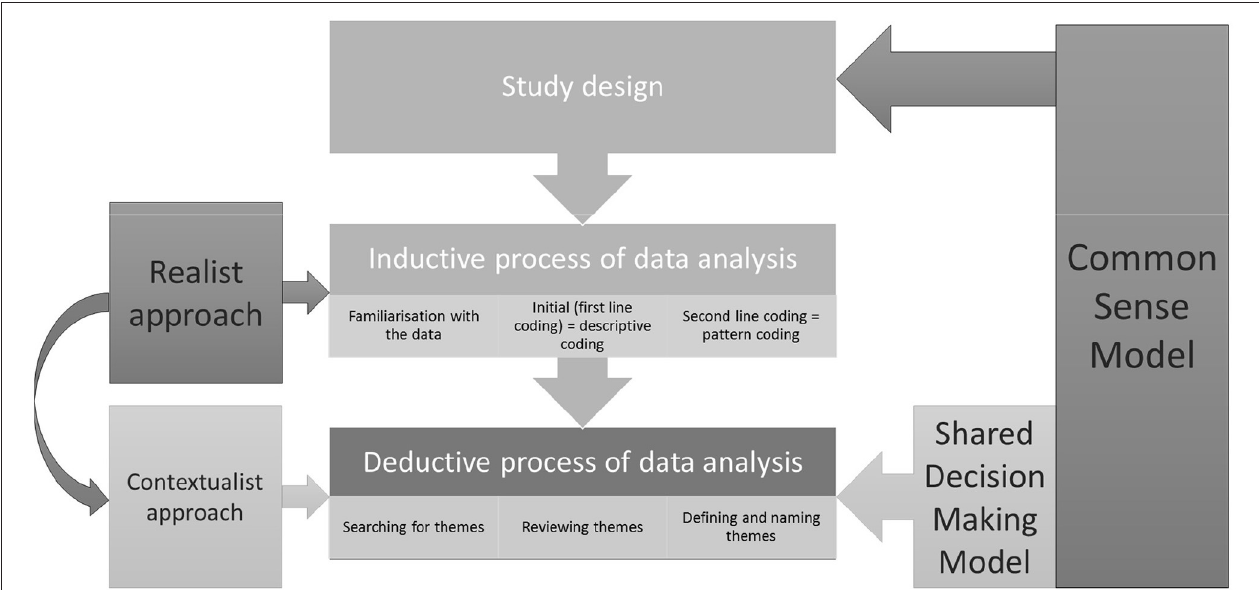
FIGURE 1 | Data analysis